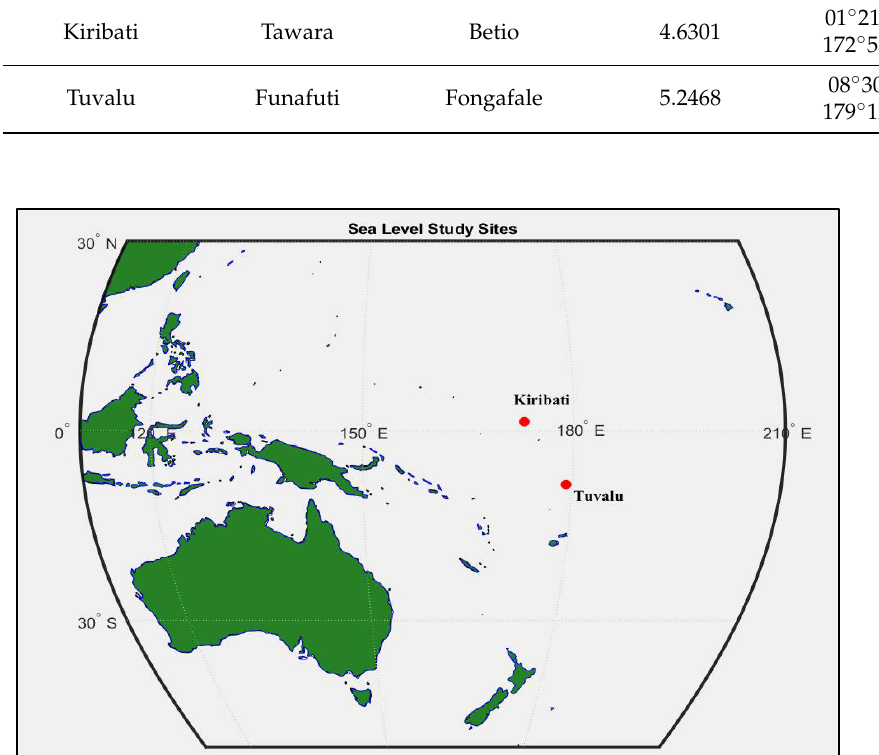
Figure 1. Study site map showing locations of both countries (Kiribati and Tuvalu) in the South Pacific Ocean.